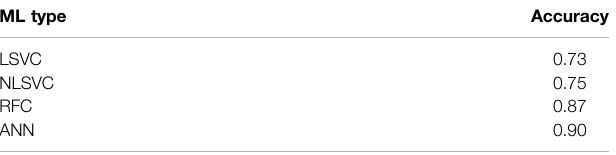
TABLE 1| Comparison ofvalidationset accuracy for ML event classi fi cation using a linear support vector classi fi er (LSVC), a non-linear support vector classi fi